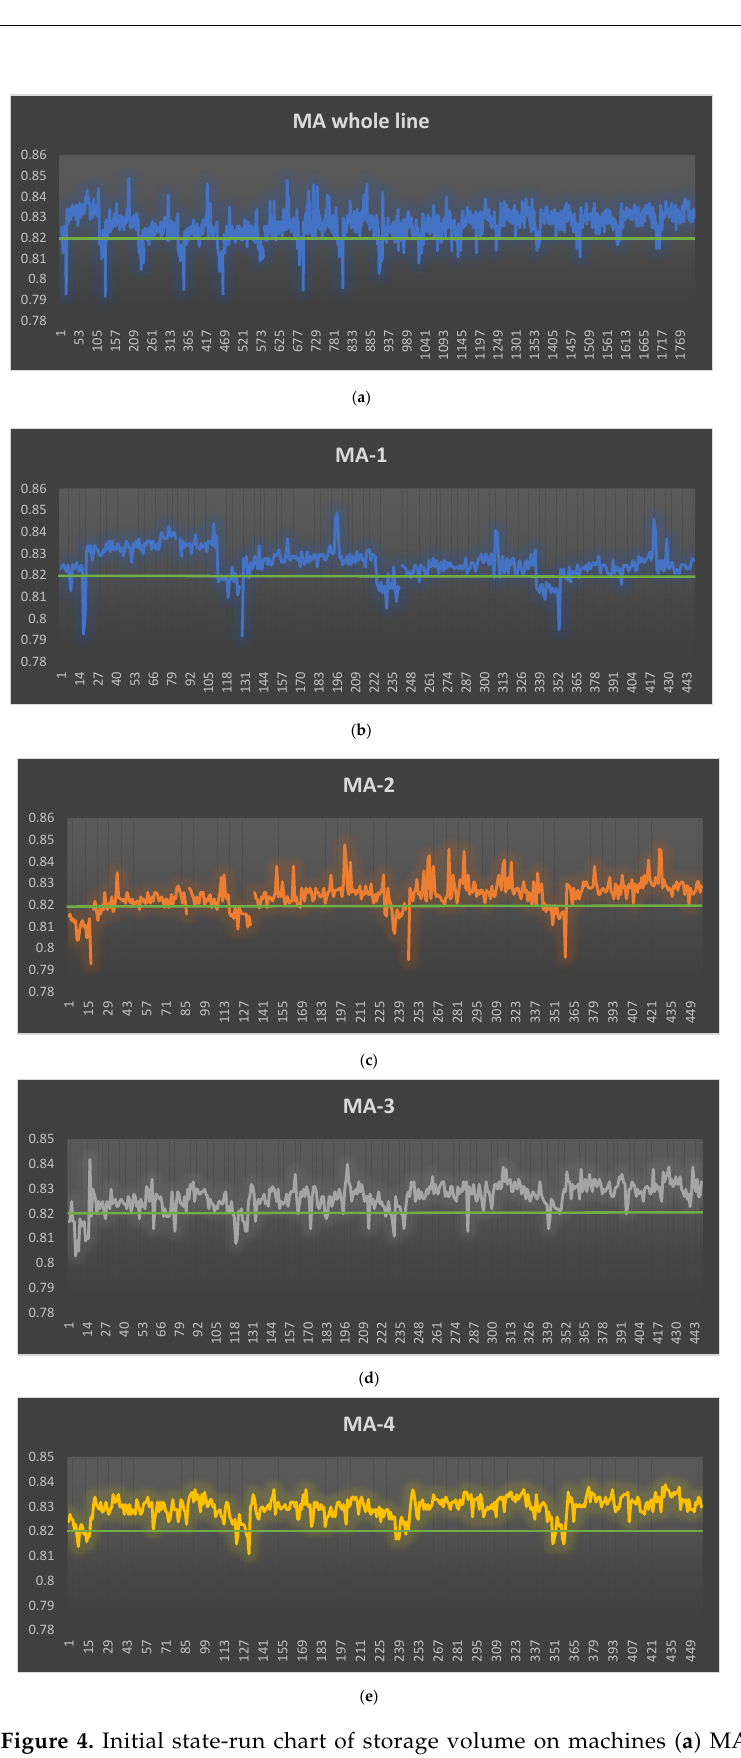
Table 3. The performance of initial state of the machine.